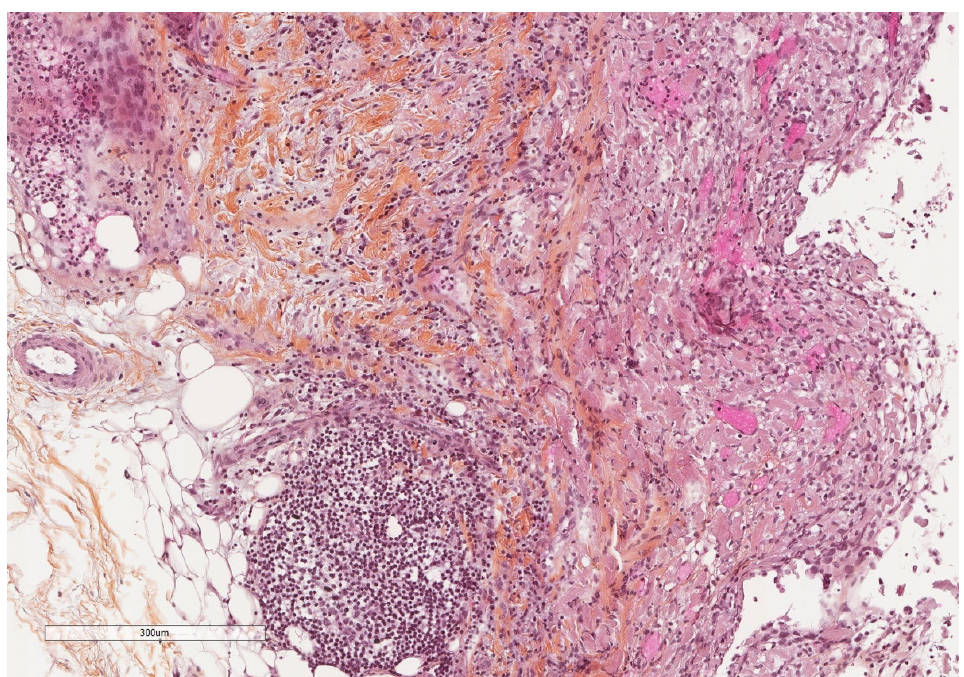
Figure 6. Microscopic image of a mildly thickened pleura (adipose tissue at the left, pleural cavity at the right) showing some chronic inflammation. Hematoxylin, eosin, saffron staining (×100).